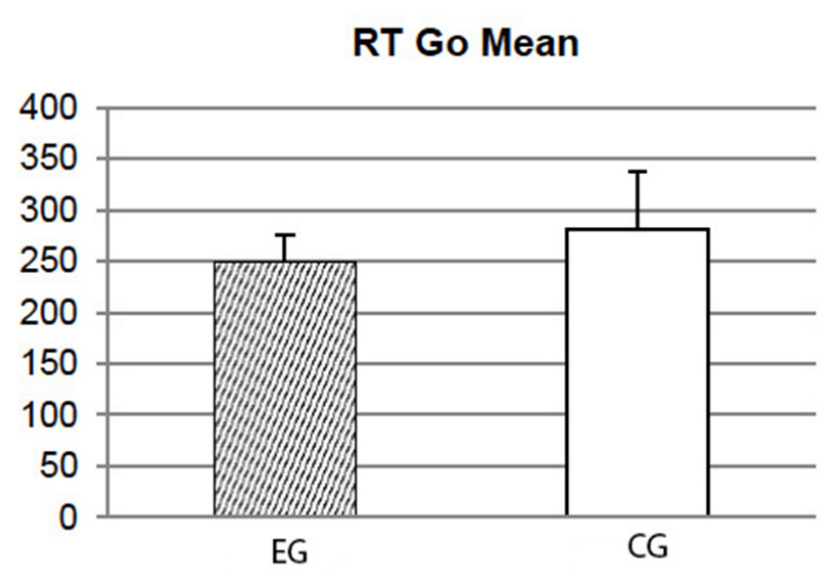
Figure 4. Results at the Go/NoGo task: effects on mean RT to Go stimuli.